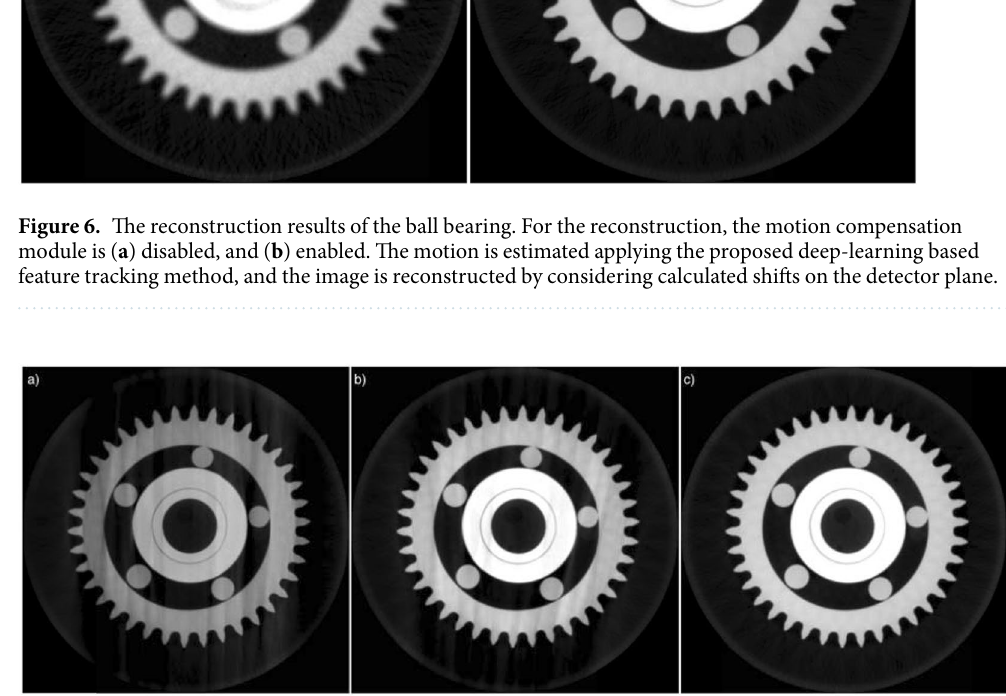
Figure 7. The reconstruction results of the ball bearing. The images are reconstructed with ( a ) projection data with angular coverage of 180°, ( b ) corrected projections with the proposed methodology (same input data as for a), and ( c ) projection data with angular coverage of